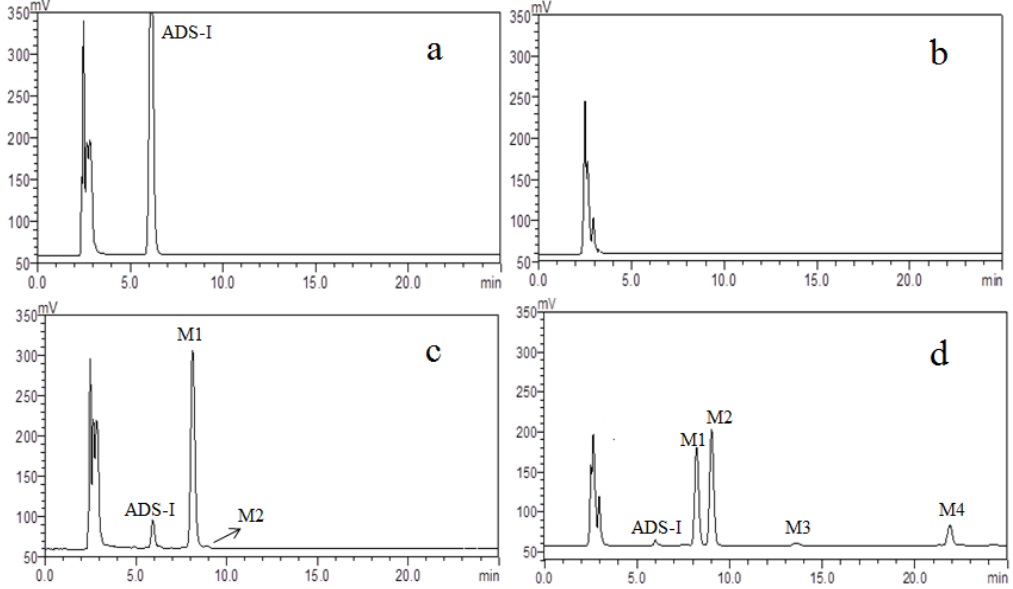
Figure 2. HPLC–ELSD chromatograms of ( a ) 0 h control incubation with ADS-I; ( b ) 72 h control incubation without ADS-I; ( c ) 24 h incubation with ADS-I; ( d ) 72 h incubation with ADS-I.